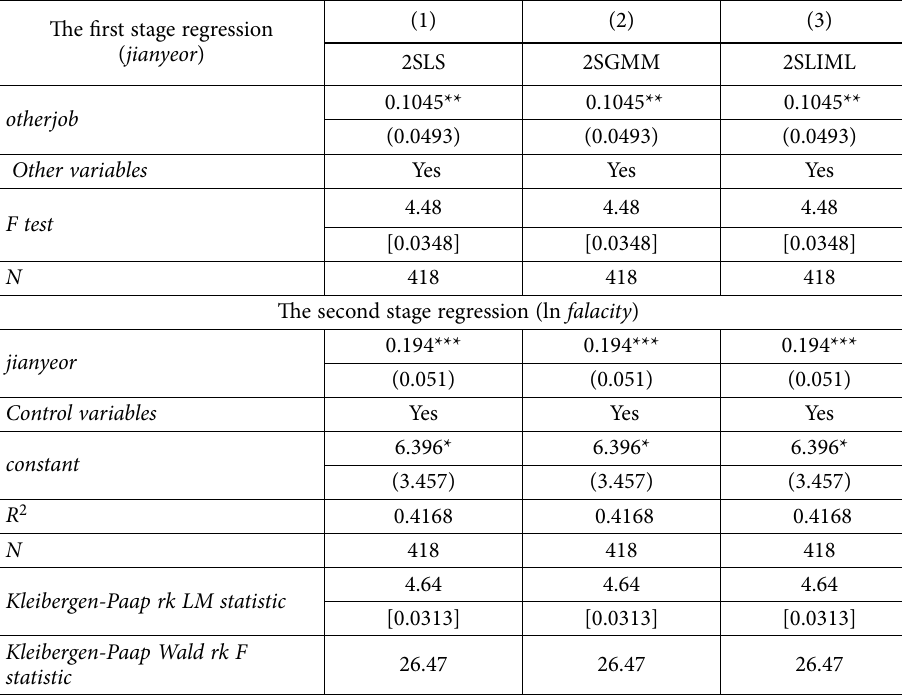
Table 3. The regression results of 2SLS The first stage regression ( jianyeor